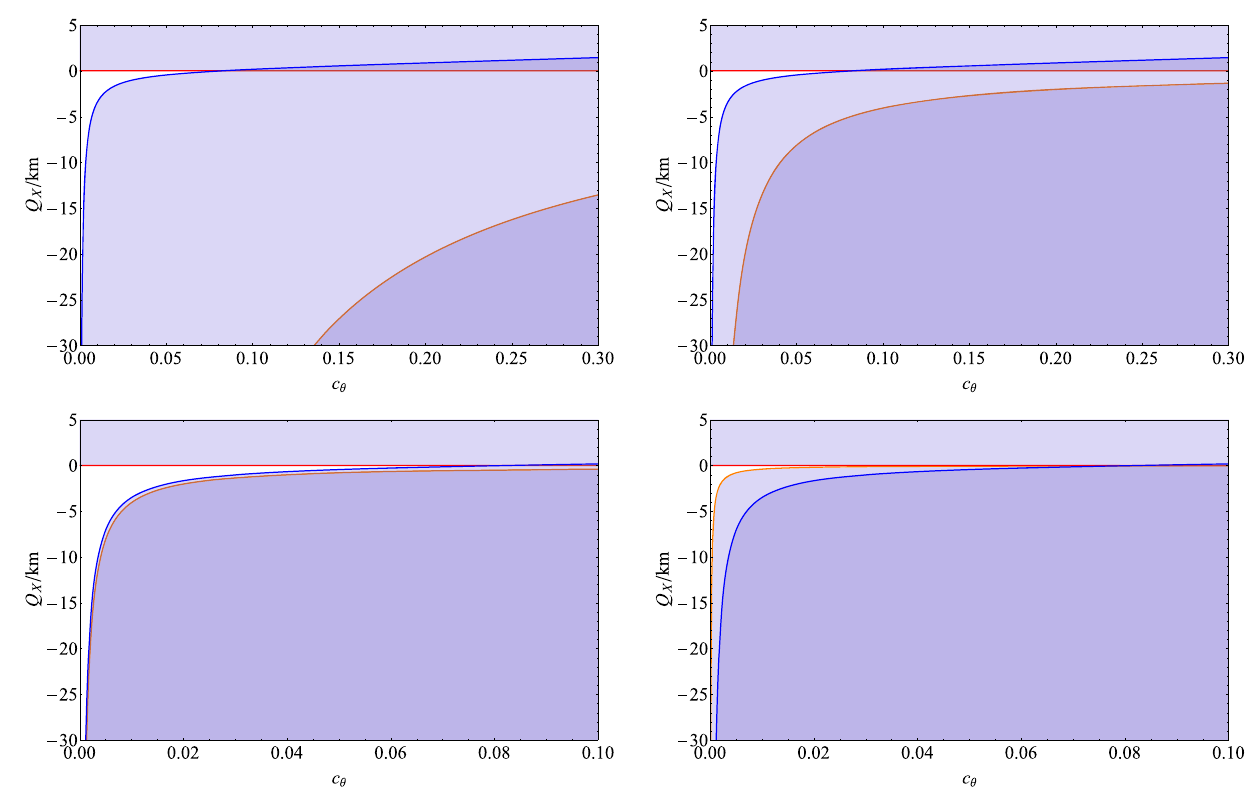
Fig. 5 The allowed parameter region (white region) for the charge Q X of the Sun and and the velocity c θ of the particles along the direction of the internal space. The red horizontal line and orange curve corre- spond to the constraint (117), whereas, the blue curve corresponds to